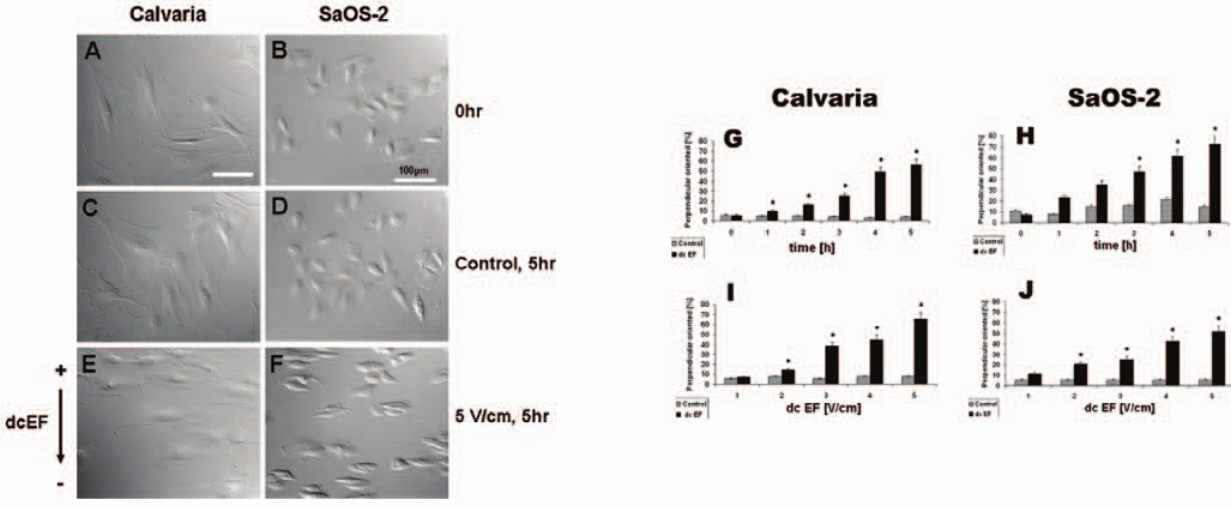
Figure 1. Time- and voltage-dependent cell shape alteration of osteoblast-like cells in a dcEF. DIC micrographs showing perpendicular orientation and elongation of calvaria (A,C,E) and SaOS-2 (B,D,F) cells before (A,B) and after (E,F) exposure to a dcEF of 5 V/cm for 5 h. Control cells (C,D; 5 h, no dcEF) displayed no major alteration in shape or orientation. Graphs indicating the percentage of perpendicular-orientated cells with or without electric stimulation as a function of time (G,H, at 5 V/cm) or voltage (I,J, after 5 hours). Means and standard deviations are shown. Numbers of cells scored: 1000–1500 in total for each time or voltage level. * indicates P , 0.05.